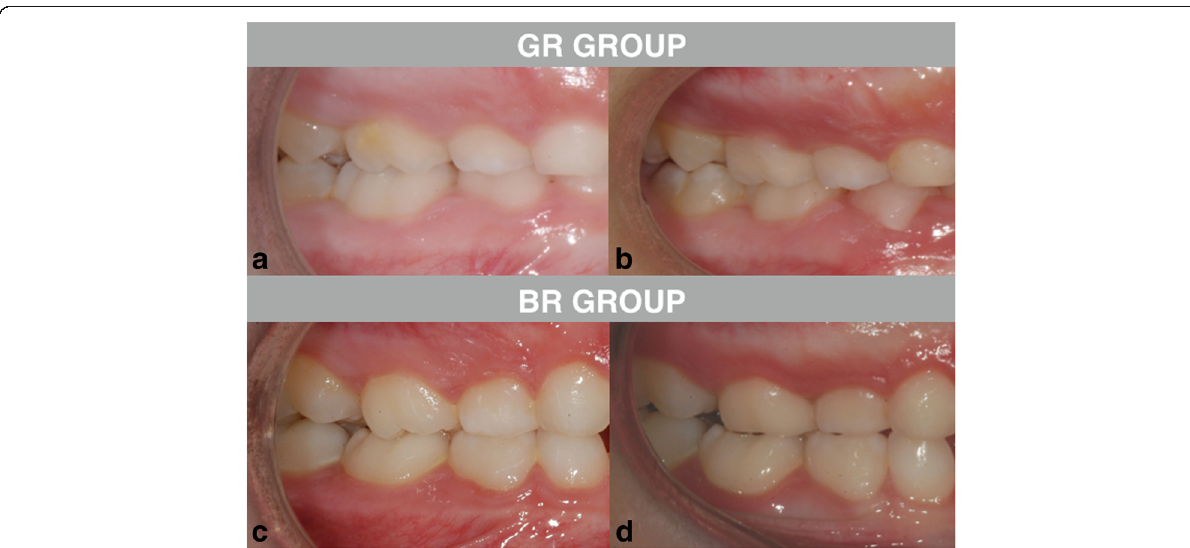
Fig. 3 Examples of Class II molar relationship at T1 and T2 for good and bad responder. a Patient GR ( good responder ) at T1. b Patient GR at T2. c Patient BR ( bad responder ) at T1. d Patient BR at